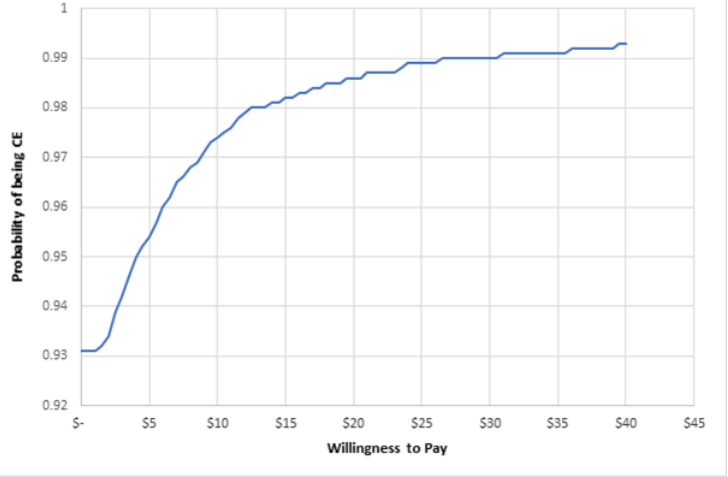
Figure 2. Cost–effectiveness acceptability curve.